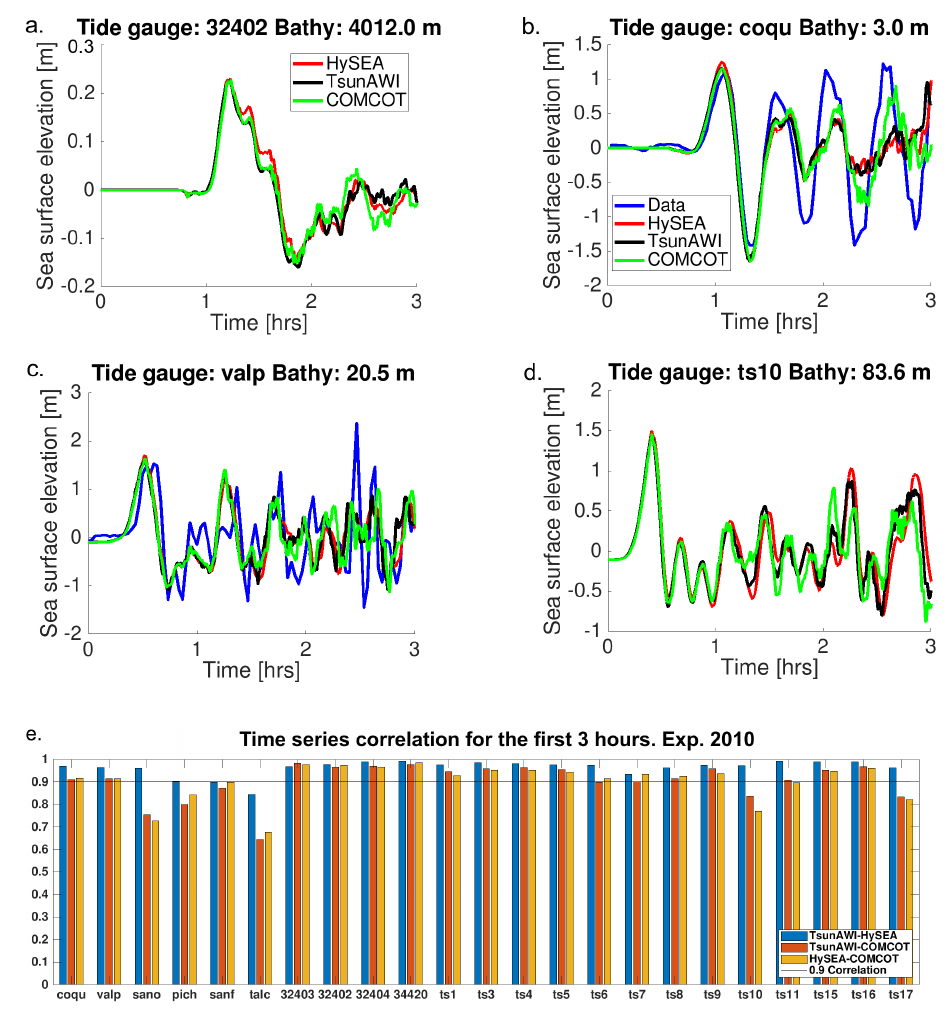
Figure 4. Time series and correlations obtained for all models in Experiment 2010 at selected forecast points. Results shown only for Manning n = 0.025. ( a ). Time series results for the DART 32402. ( b ). Time series results for the “coqu” tide gauge. ( c ). Time series results for the “valp” tide gauge. ( d ). Time series results for the “ts10” tide gauge. ( e ). Summary of correlations for Experiment 2010 based on a Manning value of n = 0.025. The corresponding correlation values are listed in Table